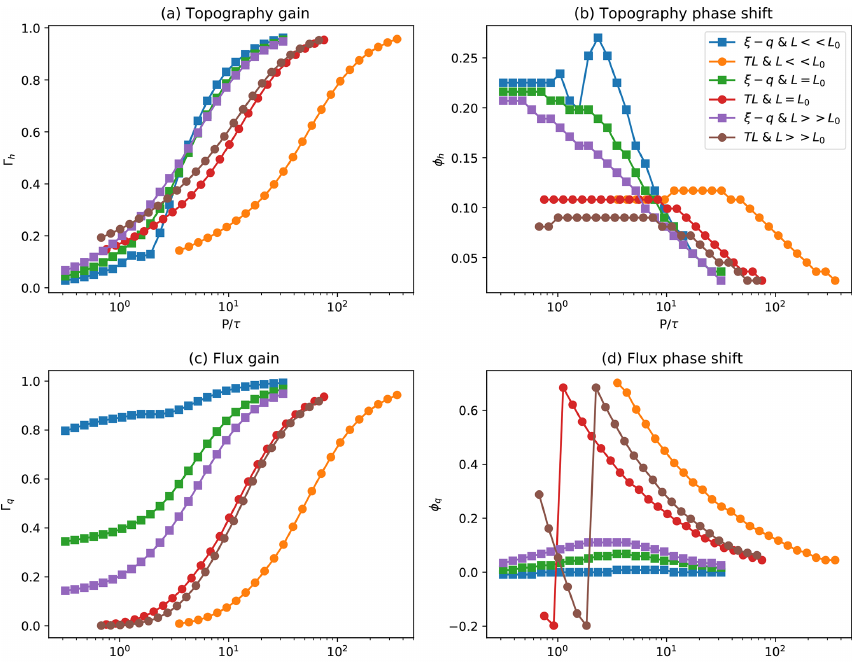
Figure 11. Computed (a) gain, (cid:48) h , and (b) phase shift, φ h , of the response of the system shape as a function of the period of the imposed periodic incoming flux normalized by the system’s response time for constrained ( L < L 0 ), intermediary ( L = L 0 ), and open ( L > L 0 ) systems using the ξ – q and TL models. Computed (c) gain, (cid:48) q , and (d) phase shift, φ q , of the outgoing sedimentary